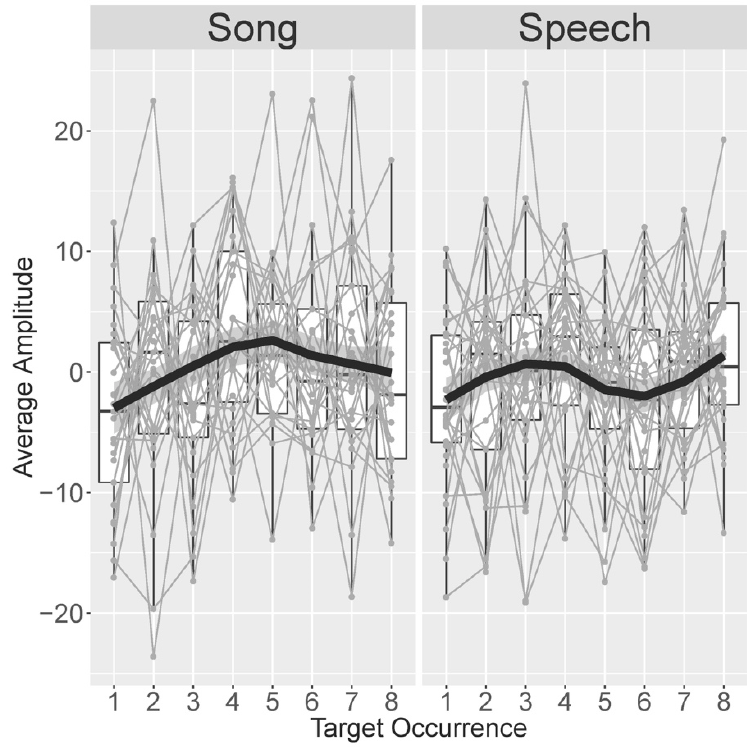
Figure 6. Average electroencephalography (EEG) amplitude in µ V (averaged over blocks) in the early (250–500 ms) time window across the eight target occurrences in the familiarization phase in song (left panel) and speech (right panel). Gray lines connect individual participants’ averages, indicated by gray points. The black lines provide a locally estimated scatterplot smoothing (LOESS)-smoothed development averaged over participants.